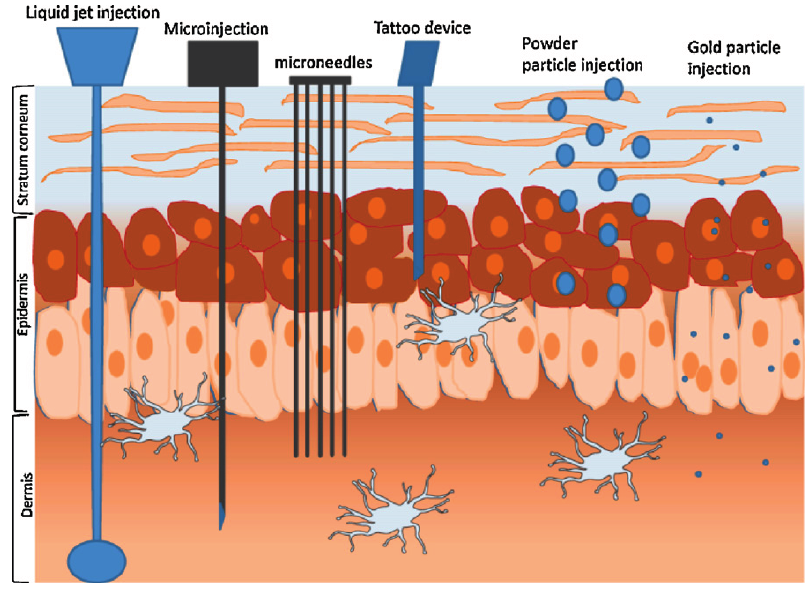
Figure 10. Methods for intradermal injection. (Reprinted from [93] with permission.